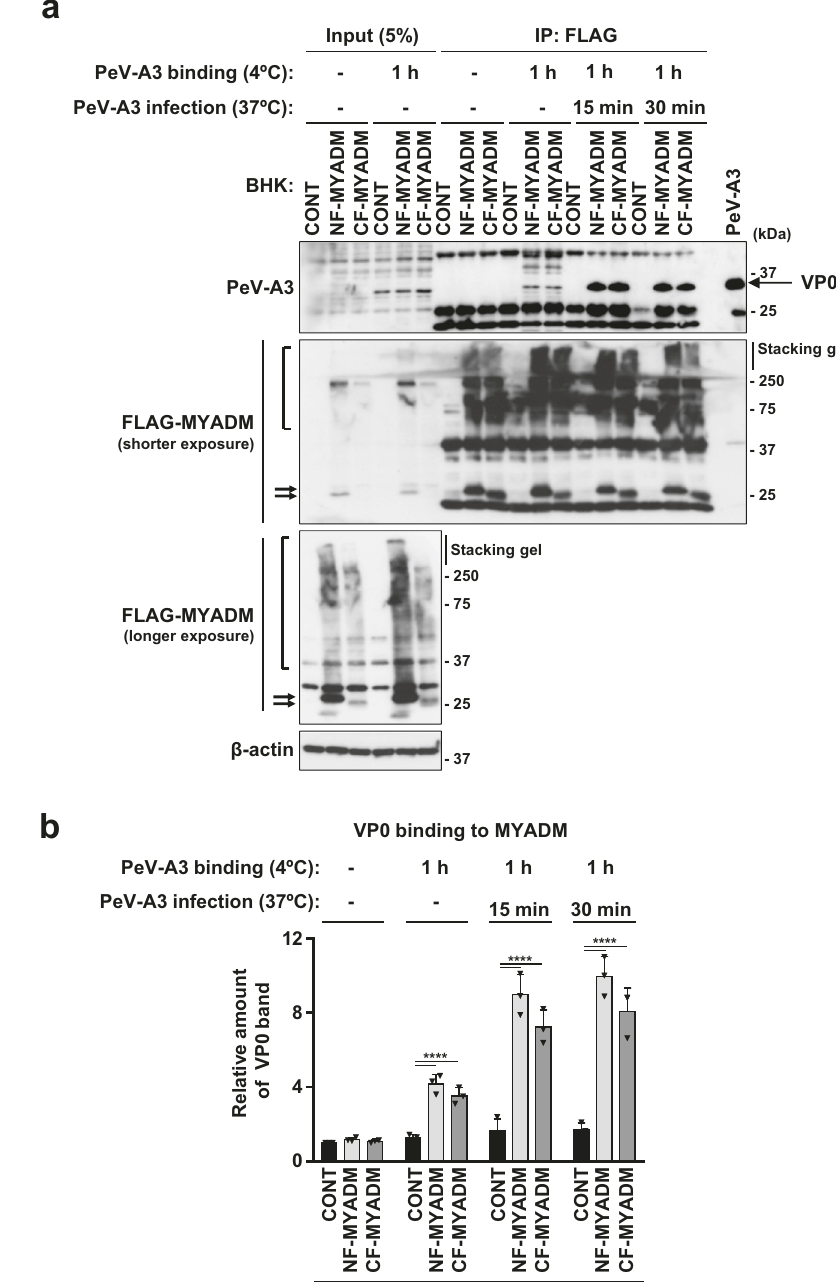
Fig. 5 | PeV-A3 capsid proteins interact with MYADM. a , b The indicated cells were incubated with concentrated PeV-A3 (A308/99) at 4°C for 1h, washed with PBS, and then incubated at37°Cfor0, 15 or 30min. The cellswere then lysed with NP-40 lysis buffer and cell lysates were immunoprecipitated with anti-FLAG anti- bodies. Immunoprecipitates (IP) and pre-IP lysates (INPUT) were characterized by Western blotting with the indicated antibodies. The intensity of the band with FLAG-tag at the N-terminus (BHK-NF-MYADM) or C-terminus (BHK-CF-MYADM) or without FLAG-tag (BHK-MYADM), as well as vector control cells (BHK-CONT) by lentiviral transduction (Fig. 2a). A MYADM antibody detected MYADM proteins in three BHK-21 cells